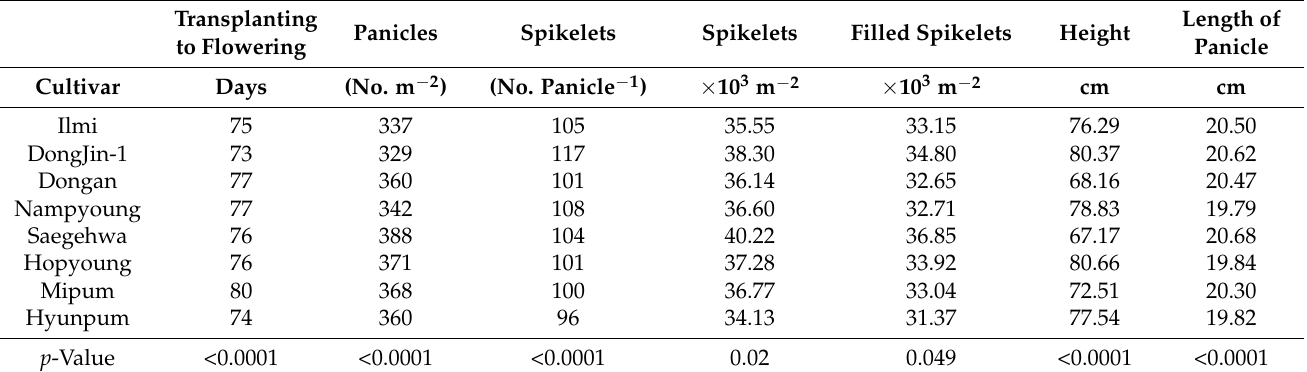
Table 3. Number of days from transplanting to flowering date, number of panicles per m 2 , number of spikelets per panicle, number of spikelets per m 2 , number of filled spikelets per m 2 , height, and length of panicle for all eight rice cultivars used in this study. All cultivars were statistically compared at α = 0.005 for each trait.